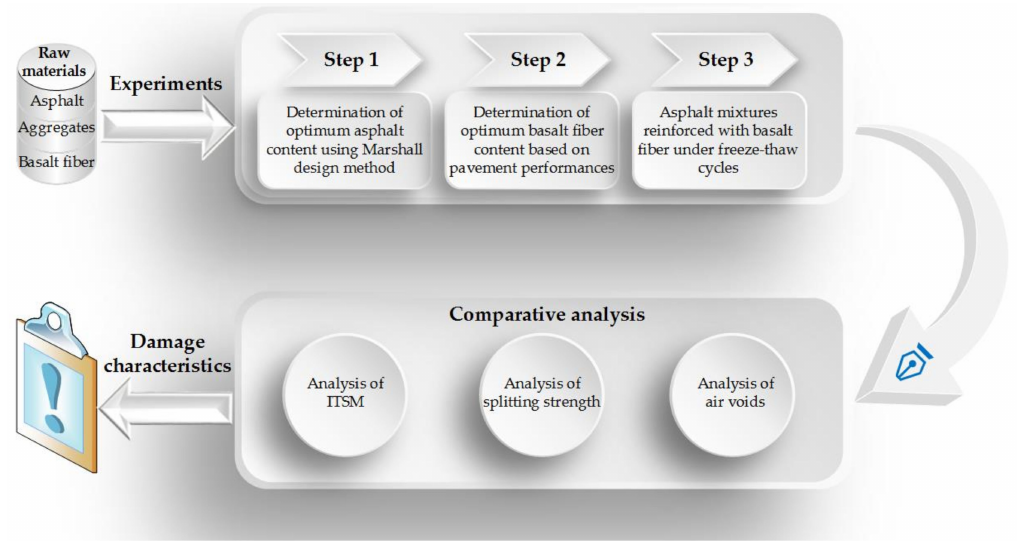
Figure 3. The research outline of this